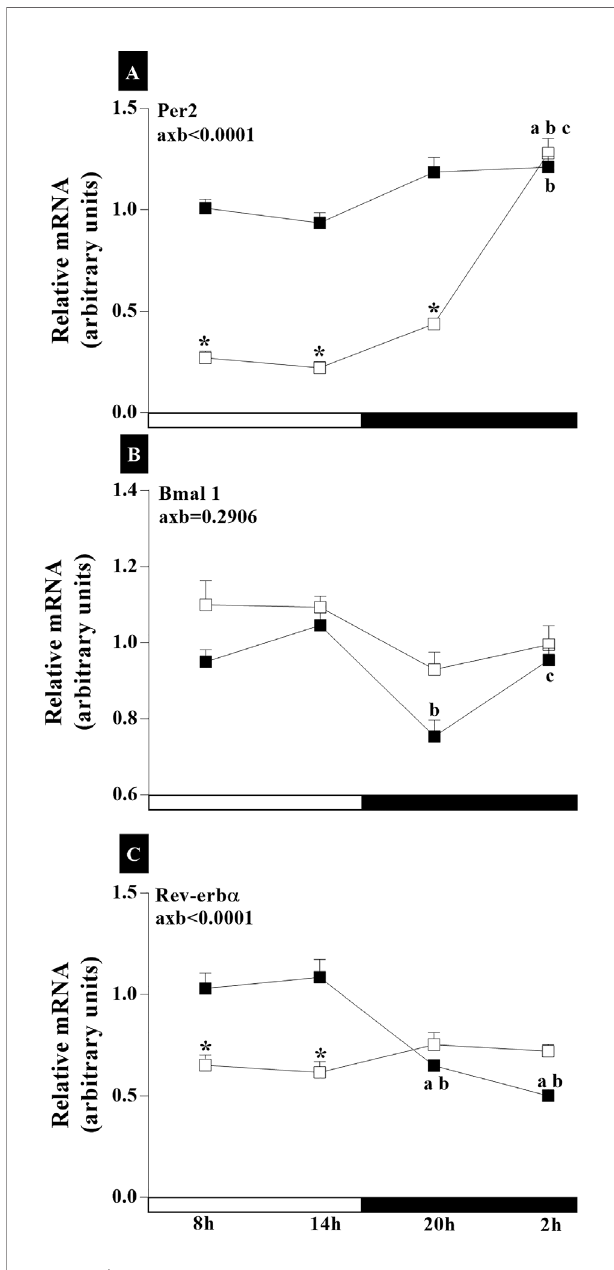
FIGURE 6 | Daily oscillations in relative mRNA expression for Per2 , Bmal1 , and Rev-erb a in the medio-basal hypothalamus. Light and dark phases are represented along the X-axis by their respective schedules. Beginning of the light phase at 07:00, when the lights are turned on. The dark phase started at 19:00. All samples were collected at six-hour intervals after the fi rst hour (i.e., 08:00), for 24 h. Light/dark cycle = 12/12 h. (A) Relative temporal expression of mRNA for Per2 , (B) Bmal1 , and (C) Rev-erb a in animals with a regular cycle on diestrus day and irregular cycle in persistent diestrus. * indicates intergroup variation at the same time: ( ■ ) Regular estrous cycle on diestrus day × ( □ ) Irregular cycle in persistent diestrus. Letters indicate temporal variation within the group. a vs. 08:00; b vs. 14:00; and c vs. 20:00. axb = age and time of day interaction. n = 3 – 7. Replicates with a variation above 0.2 were automatically excluded from the groups. DD Ct for Per2 and Rev-erb a ; relative standard curve for Bmal1